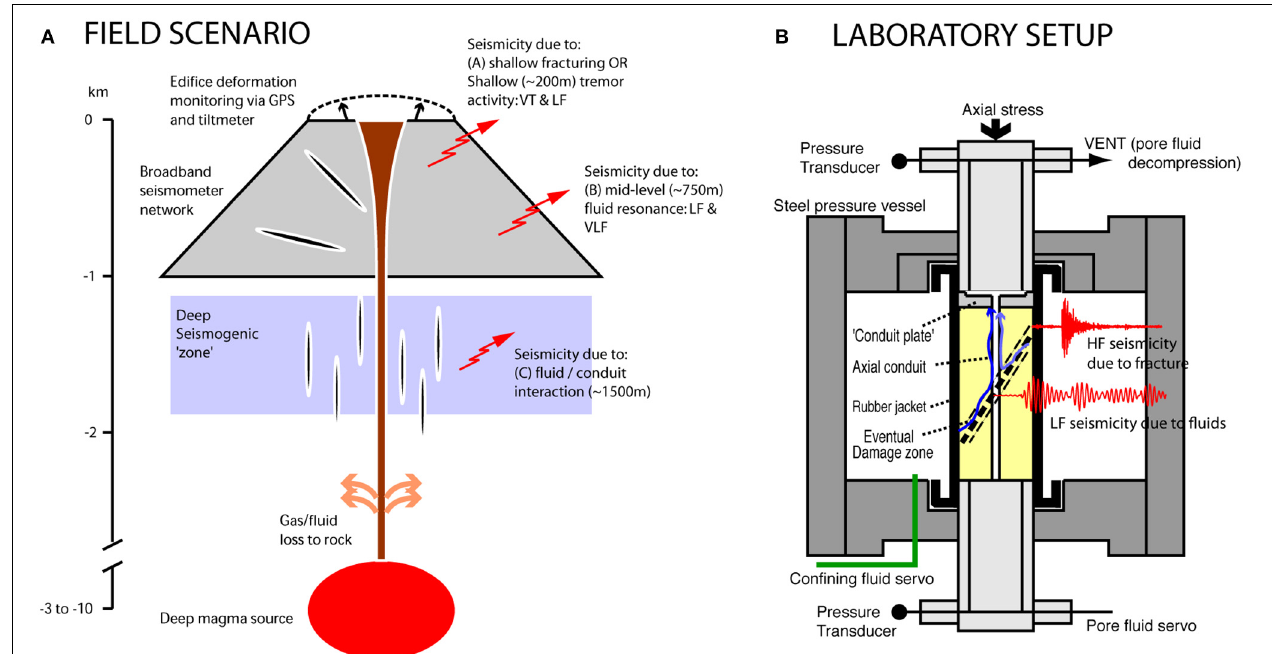
FIGURE 1 | (A) Schematic (cartoon) view of a volcanic system illustrating the likely sources of the various signals commonly detected on the edifice. A shallow zone (zone A) where fracturing dominates is postulated to exist in the uppermost part of the edifice (generating Volcano-Tectonic or VT-type activity). This gives way to seismicity due to fluid resonances, known as Low Frequency (LF) and Very-Low Frequency (VLF) activity, deeper in the edifice (zone B) as well as so-called hybrid activity which represents a combination of